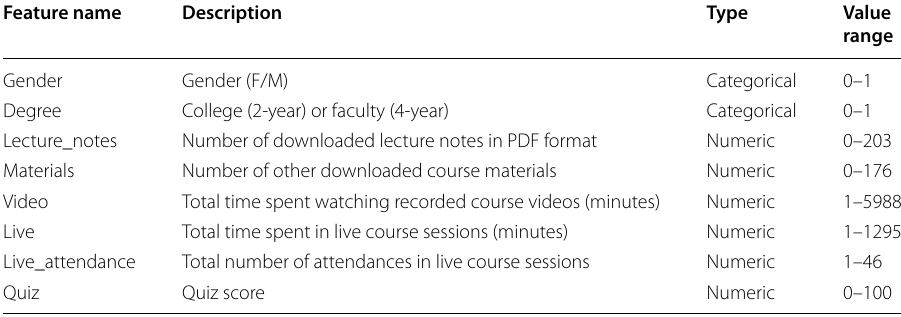
Table 1 Feature descriptions and data ranges of the dataset